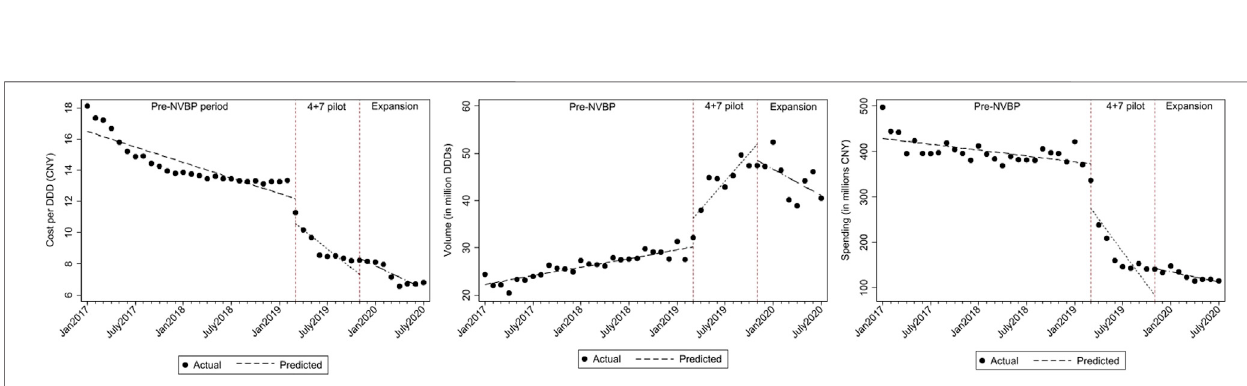
Frontiers in Pharmacology |